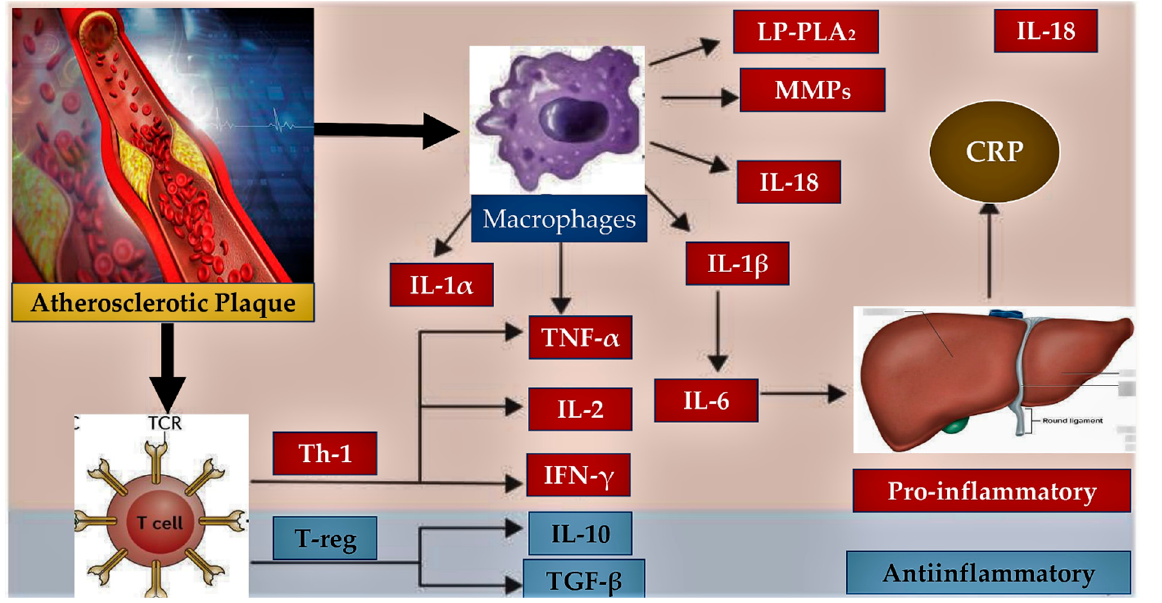
Figure 2. The inflammatory process entailed in atherosclerosis is represented. An intricate balance across pro-inflammatory and anti-inflammatory pathways emerged from preclinical and clinical trials. Inflammatory cells (macrophages and T-cells) and liver (CRP) regulate the balance that promotes endothelial dysfunction and the progression of atherosclerotic plaque through the production of molecules with a proinflammatory (red box) or anti-inflammatory (blue box) effect. Plaque rupture can be a consequence of the exacerbated inflammatory process. Abbreviations; CRP, C-reactive protein; MMPs, matrix metalloproteinases; IFN- γ , interferon-gamma; IL-1 α , interleukin-1-alpha; IL-1 β , interleukin-1-beta; IL-2, interleukin-2; IL-6, interleukin-6; IL-10, interleukin-10; IL-18, interleukin-18; Lp-PLA2, lipoprotein-associated phospholipase A2; TGF- β , transforming growth factor beta; Th-1, T-helper-1 lymphocyte; TNF- α , tumor necrosis factor alpha; T-reg, regulatory T lymphocyte.